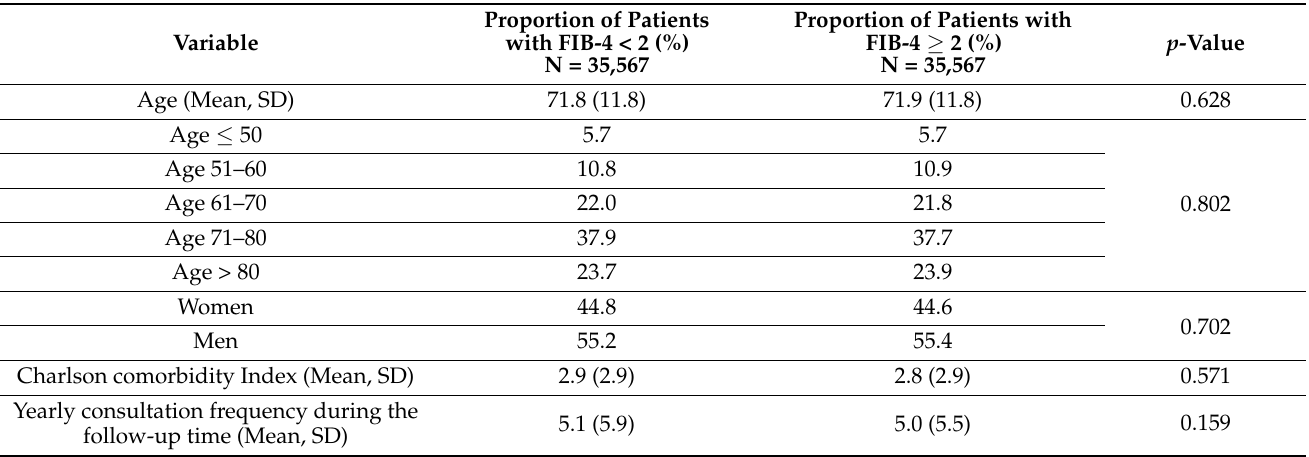
Table 2. Basic characteristics of the study sample after 1:1 propensity score matching by sex, age, and yearly consultation